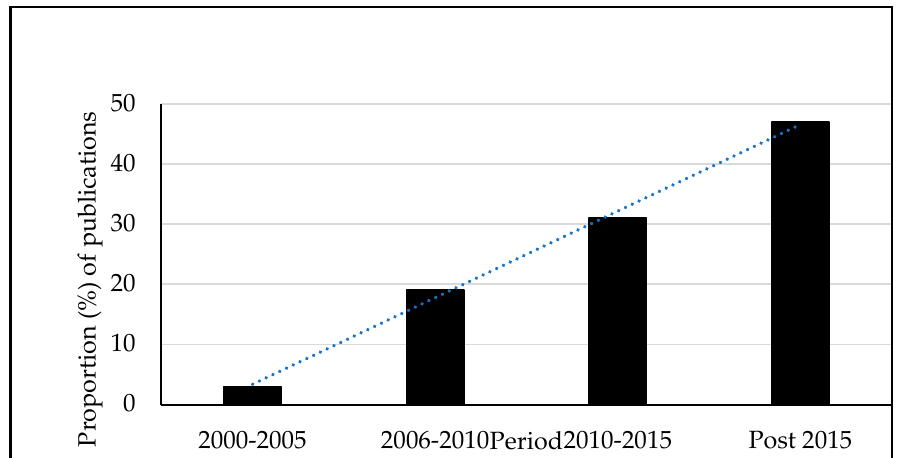
Figure 2. The distribution of publications between 2000 and 2022.